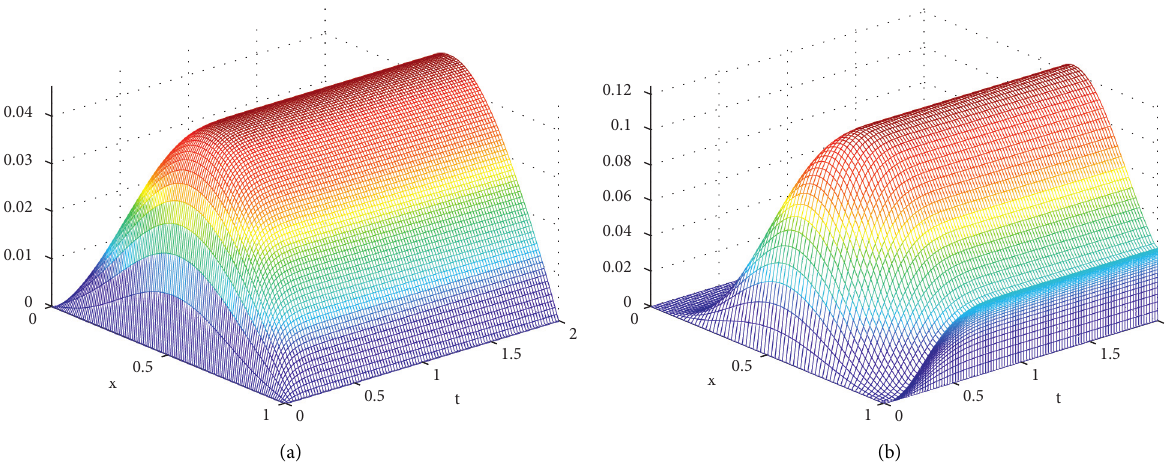
Figure 2: 3D view of solution of Example 1, with boundary layer, on (a) ε � 1 and (b) ε � 2 − 20 .